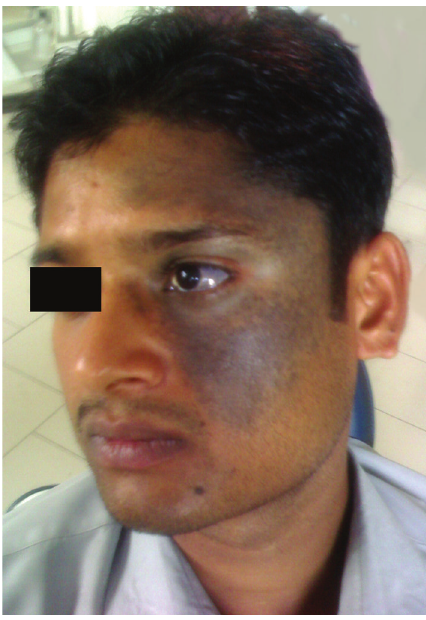
Figure 1: Extraoral involvement of nevus of Ota.